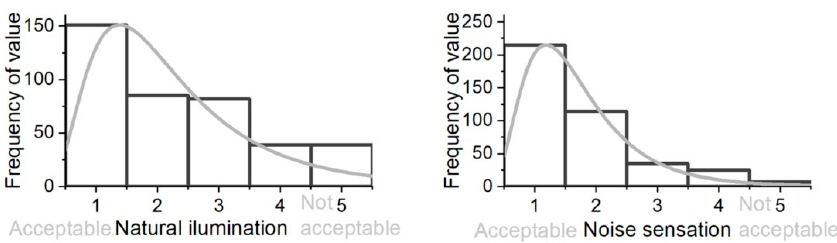
Figure 3. Acceptance level perception (natural illumination and noise). Multiple answers during the monitoring period in the point-in-time comfort environmental survey.